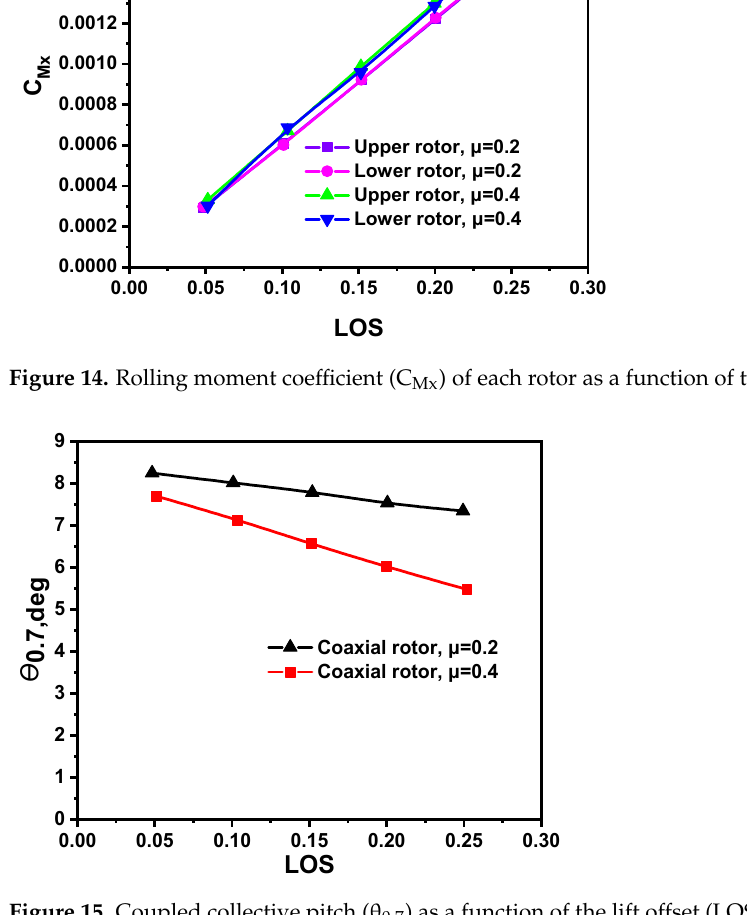
Figure 16. Lateral cyclic pitch of upper and lower rotors ( B (cid:2869)(cid:2931)(cid:2926) and B (cid:2869)(cid:2922)(cid:2925) ) as a function of the lift offset (LOS).